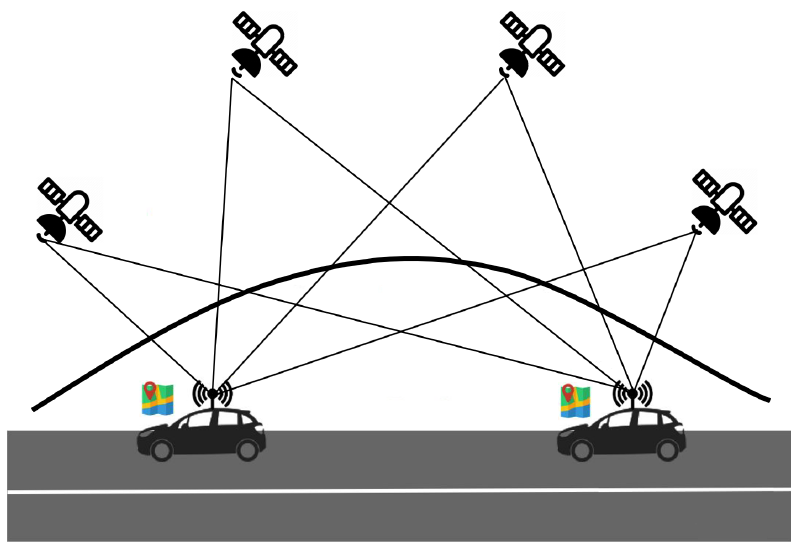
Figure 1. Global Navigation Satellite System (GNSS) in a Vehicular Ad-Hoc Network (VANET)